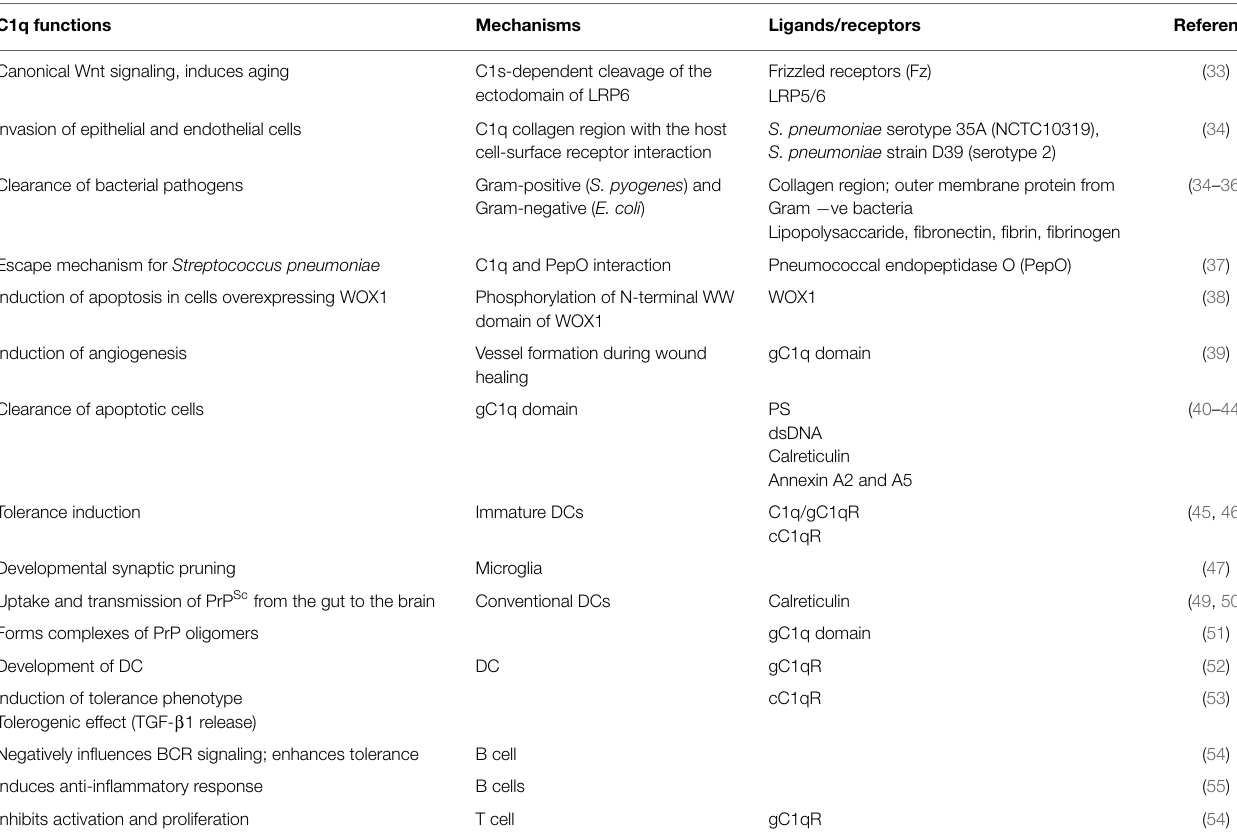
TABLE 1 | Emerging non-complement functions of C1q